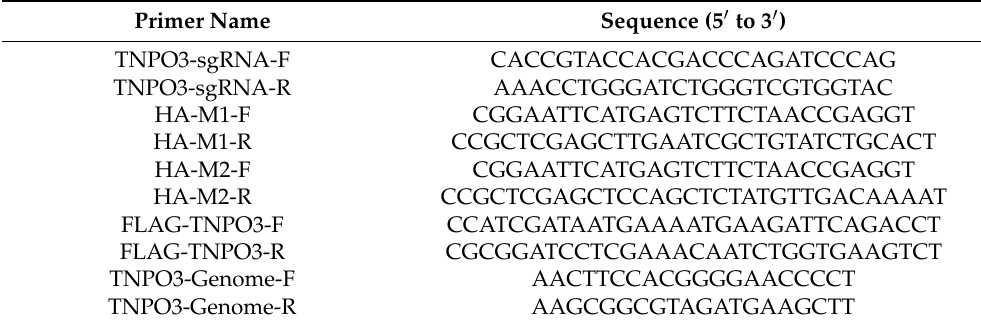
Table 1. Primers used in this